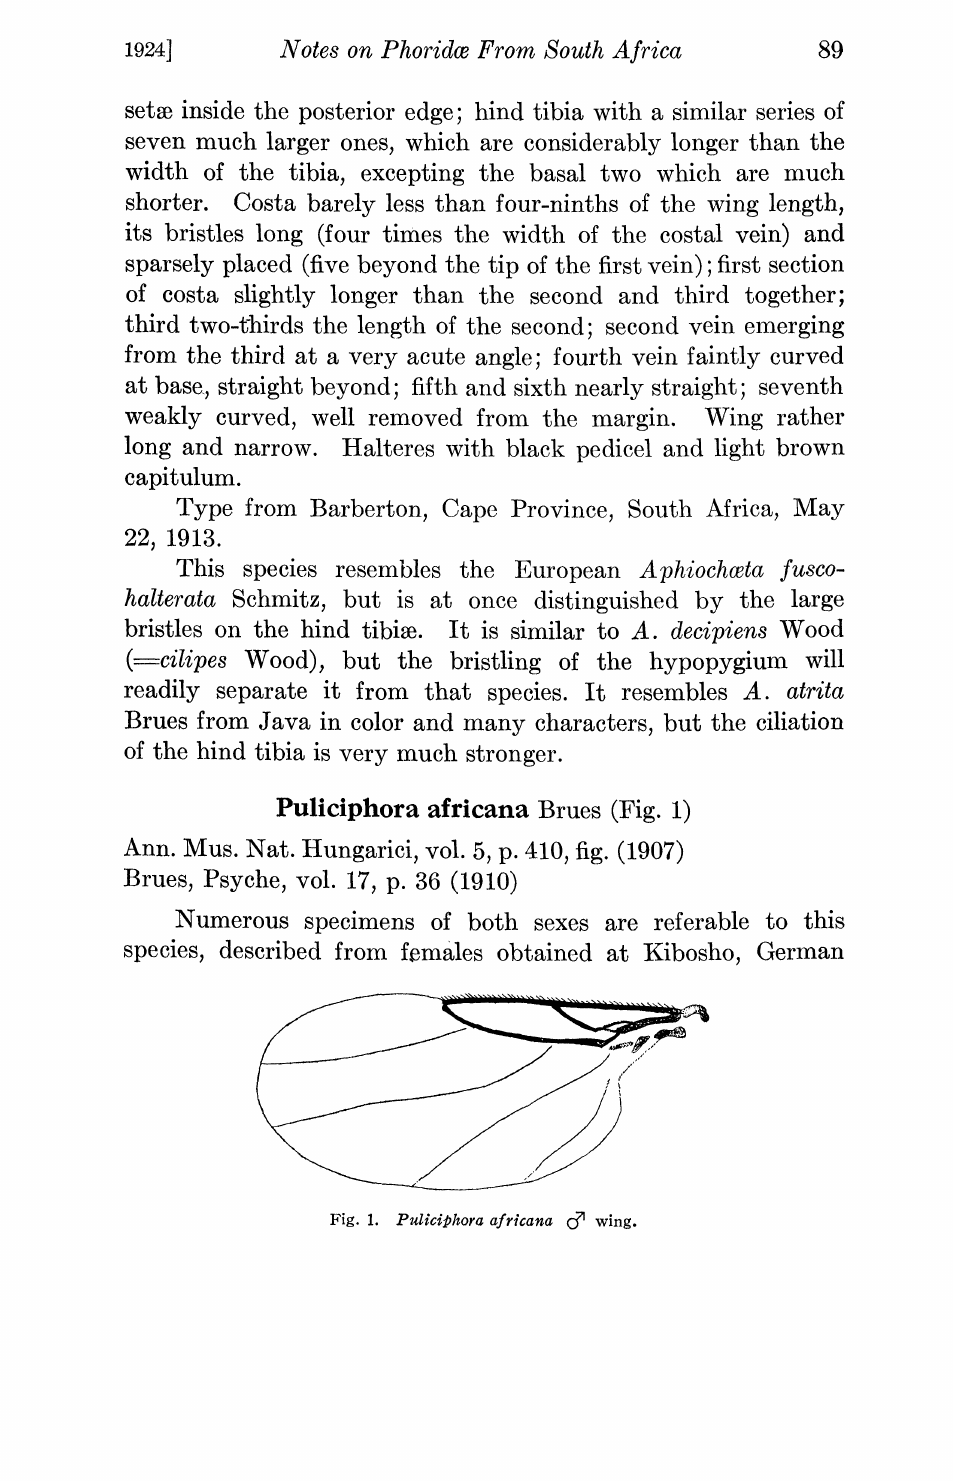
Fig. 1. Puliciphora africana C